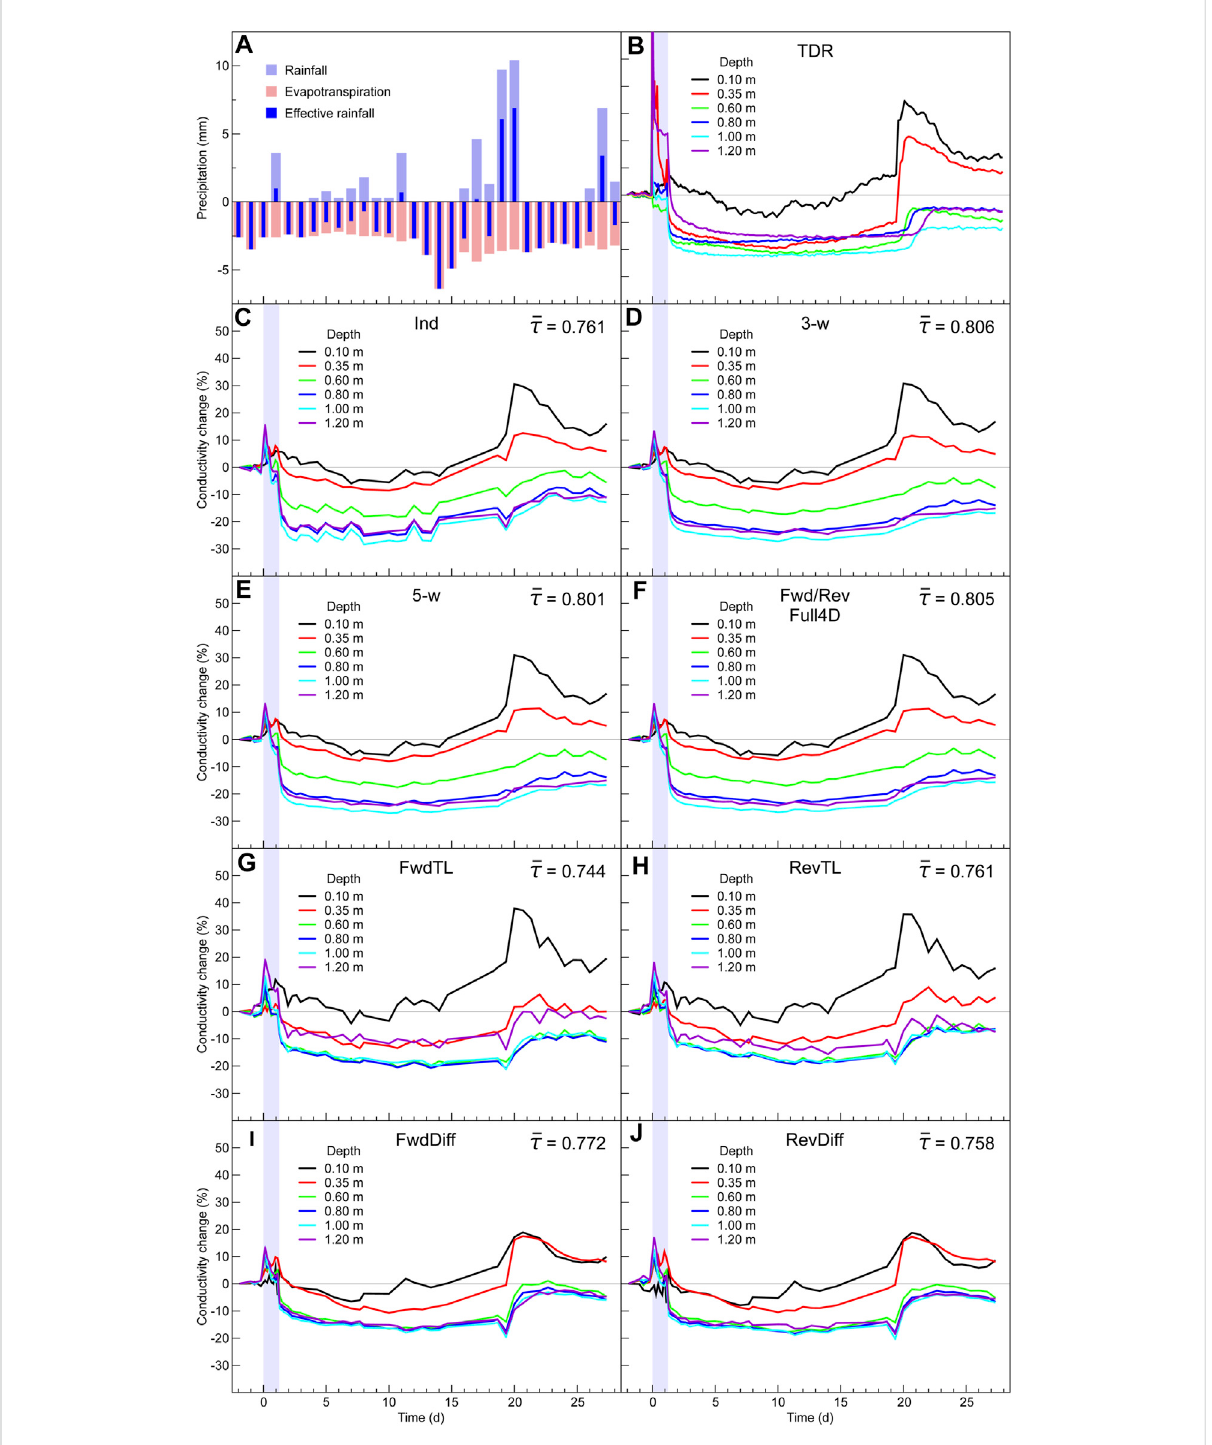
FIGURE 14 (A) Rainfall, estimated evapotranspiration and effective rainfall during the leak experiment (B) Relative changes in conductivity measured by the TDR probes (data © University of Birmingham) (C – J) relative changes in conductivity extracted from the independent, 3-window 4D, 5-window 4D, forward/reverse full sequence 4D, forward time-lapse, reverse time-lapse, forward difference and reverse difference inversions respectively. (cid:1) τ is the average Kendall rank correlation coef fi cient between the TDR and inverse model conductivity changes across all TDR sensor